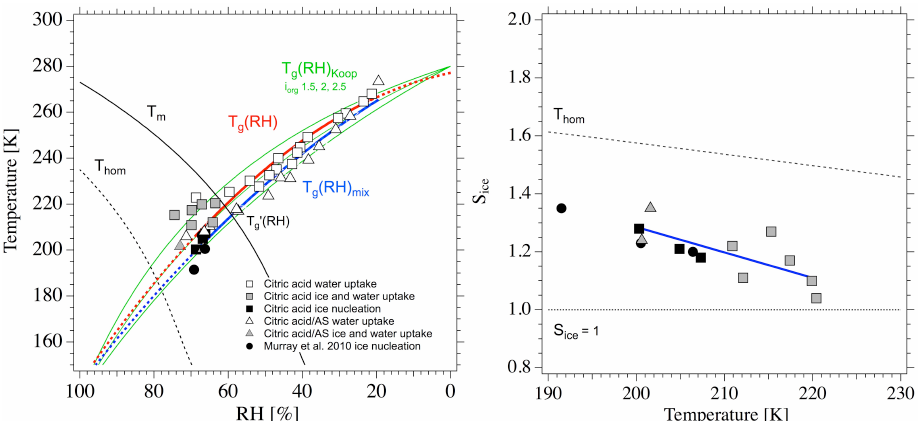
Fig. 4. State diagram and plot of ice saturation ratios for all water uptake and ice nucleation experiments performed on citric acid and citric acid/ammonium sulfate particles. Black circles in this figure represent ice nucleation on citric acid as observed during cloud chamber experiments from Murray et al. (2010). Other symbols, lines and notation are the same as in Fig. 2. Citric acid T g (RH) Koop curves (green) were calculated using T g (dry) = 280.1K and k GT = 3 . 18 for van’t Hoff factors ( i org ) 1.5, 2 and